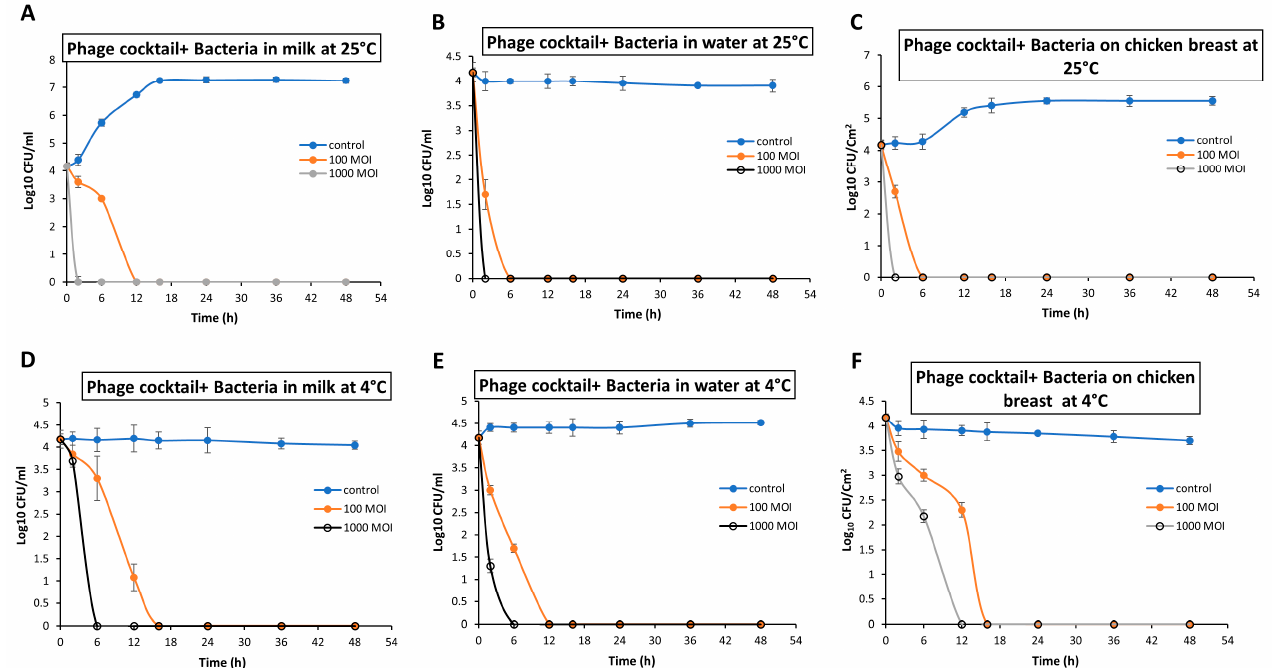
Figure 7. Biocontrol of S. Typhimurium EG.SmT3 using Salmonella phage cocktail at different food matrices. ( A , D ) Application in milk, ( B , E ) application in water, and ( C , F ) application on chicken breasts. Phage cocktail at to different MOIs (100 and 1000) were added separately to each food object and incubated either at 4 °C or 25 °C for 48 h, the un-infected control consisted of phage-free bacteria with SM buffer added. Values represent mean CFU/mL with a standard deviation of three replicates of each time point.